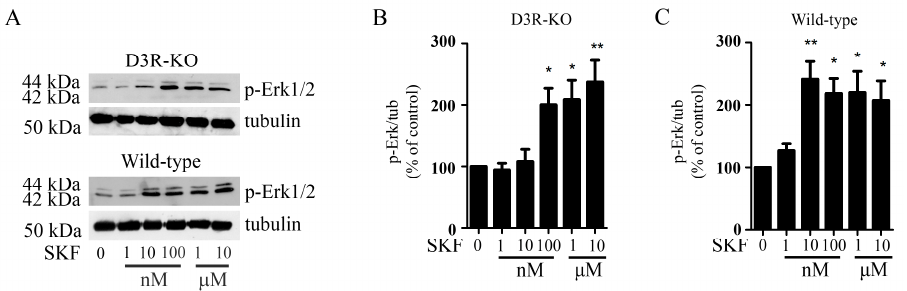
Figure 7. In mouse primary striatal neurons, interaction of D1R with D3R increases the ability of DA or D1R agonists in activating the Erk1/2 pathway. ( A ) Primary striatal neurons from D3R-KO and wild-type mice were exposed to different doses of SKF (1–10 μ M; 5 min) and analyzed for p-Erk1/2; representative WBs are shown. ( B , C ) Densitometric analysis of blots with specific p-Erk1/2 levels normalized to the corresponding tubulin levels. Bars represent the mean ± S.E.M. * p < 0.05, ** p < 0.01 vs. untreated cells. (n = 6) (Data were statistically analyzed using one-way ANOVA followed by post hoc comparison with the Bonferroni test).